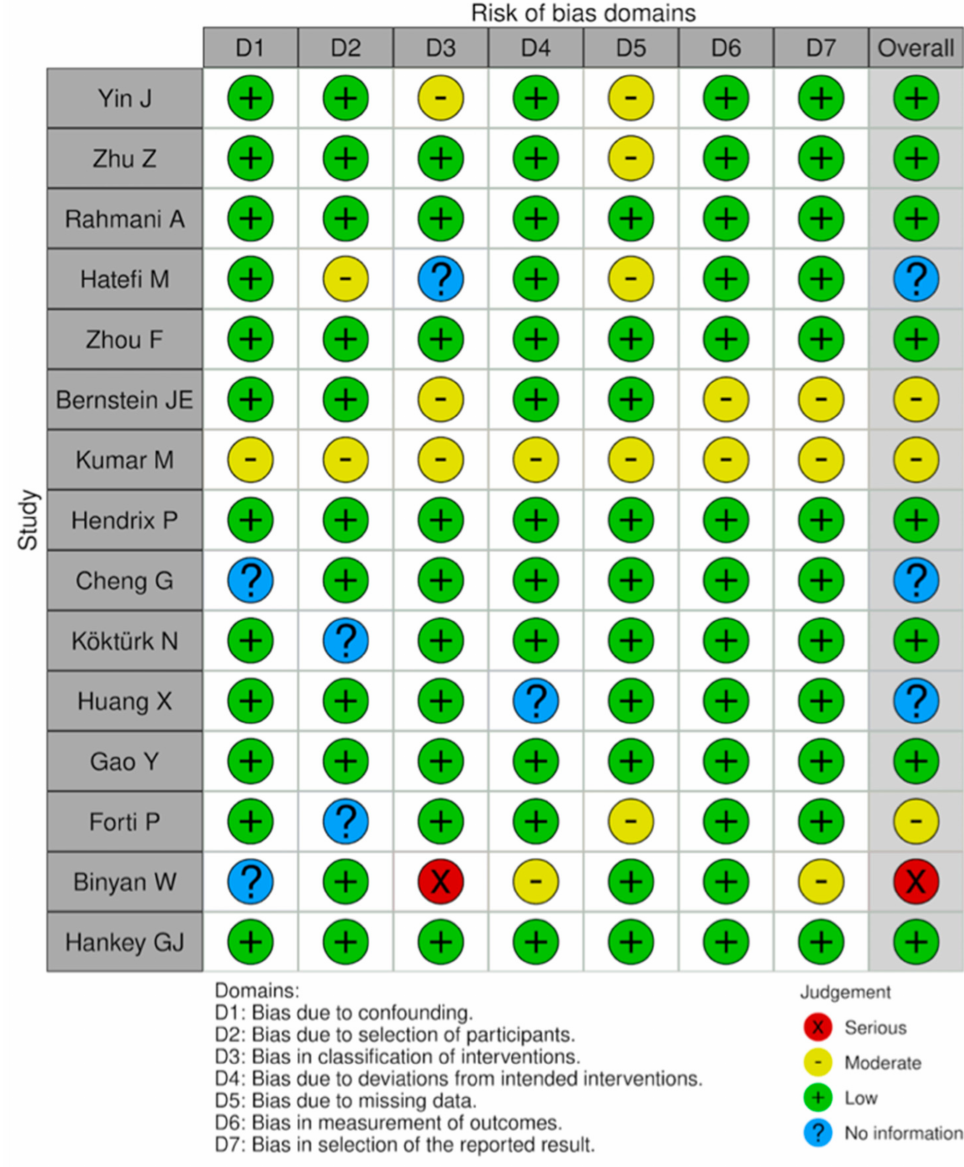
Figure 5. Risk of bias plot of NRS included in this SR